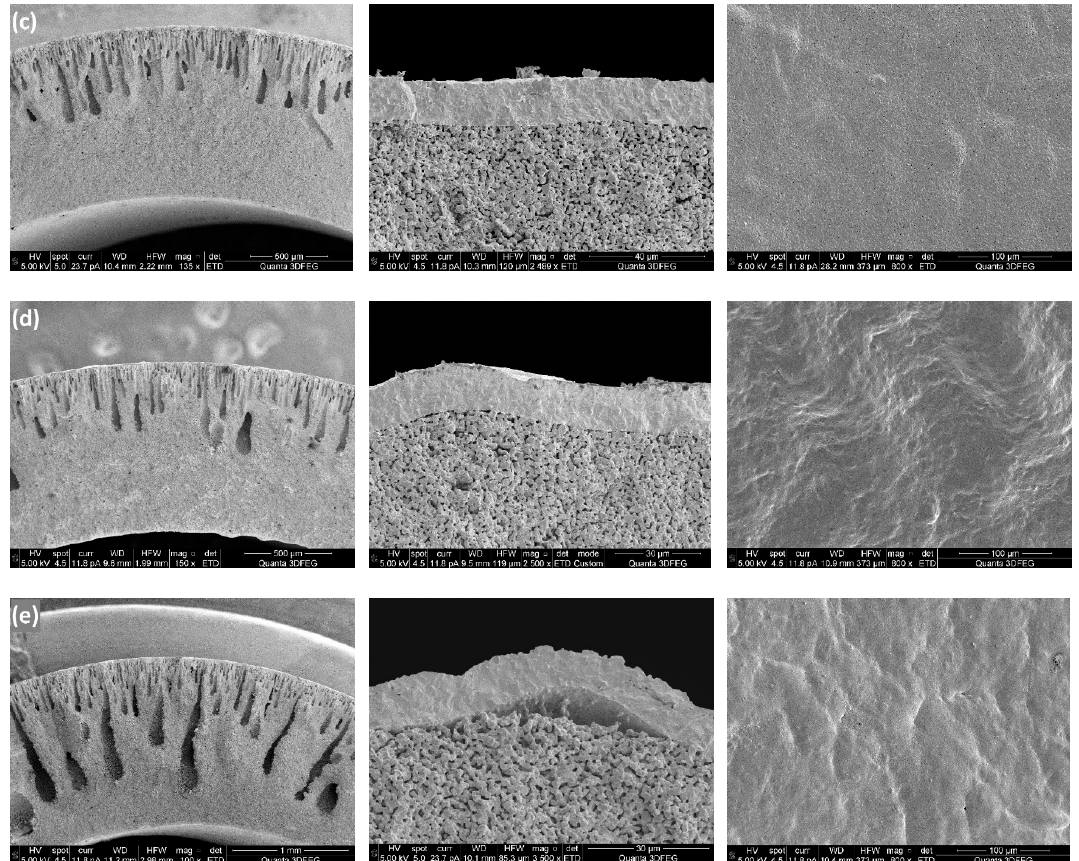
Figure 8. SEM images of MgO-CGO porous supports fabricated from slurries with ( a ) 11 wt%, ( b ) 15 wt%, ( c ) 18 wt%, ( d ) 22 wt% and ( e ) 25 wt% polymer concentrations together with the CGO layers coated inside.